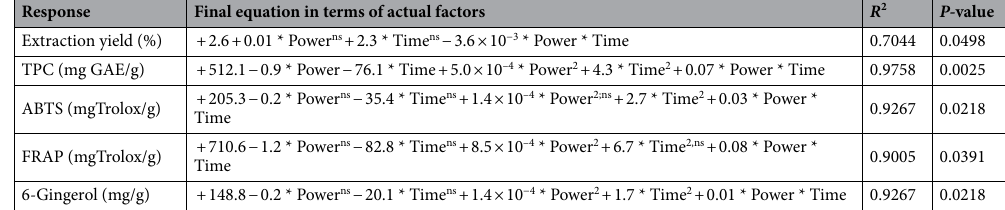
Table 2. Regression coefficients of the models for extraction yield, TPC, ABTS, FRAP, and 6-gingerol. *ns means not significant at p < 0.05.